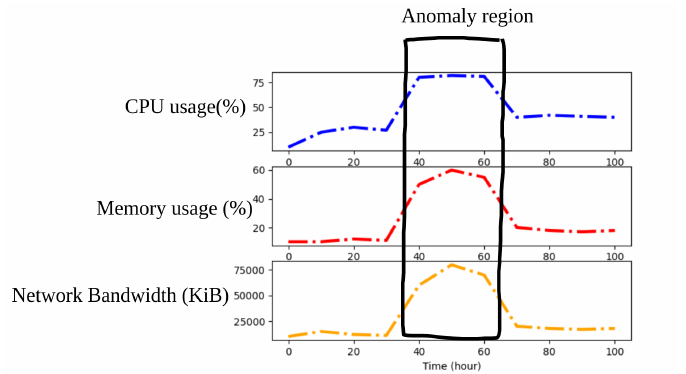
Figure 3. Multivariate time series snippet visualization with an anomalous region